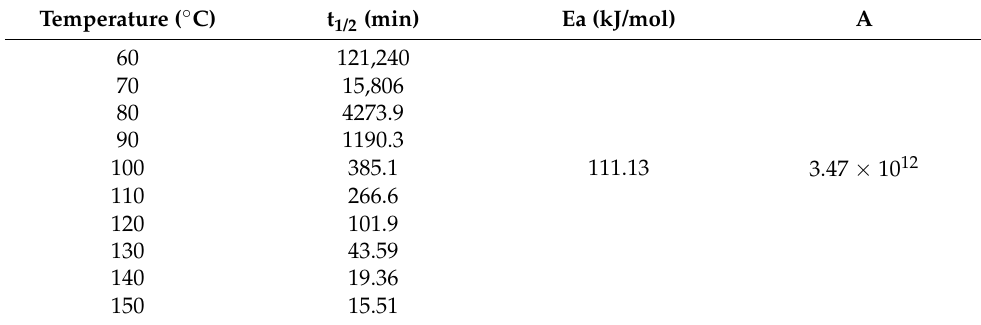
Table 3. Kinetic parameters for the thermal degradation of IPBC between 60 ◦ C and 150 ◦